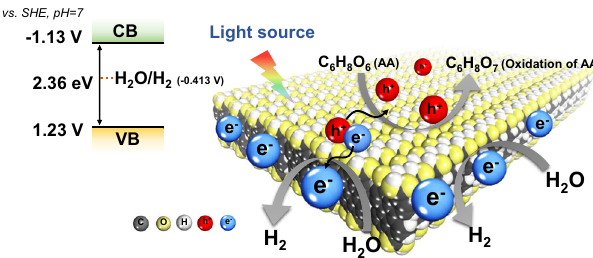
Fig. 7 Schematic mechanism of the photocatalytic HER by PTA nanosheets. Left: Band positions of PTA nanosheets. Right: Migration and reaction of photogenerated charges during the photocatalytic HER of PTA